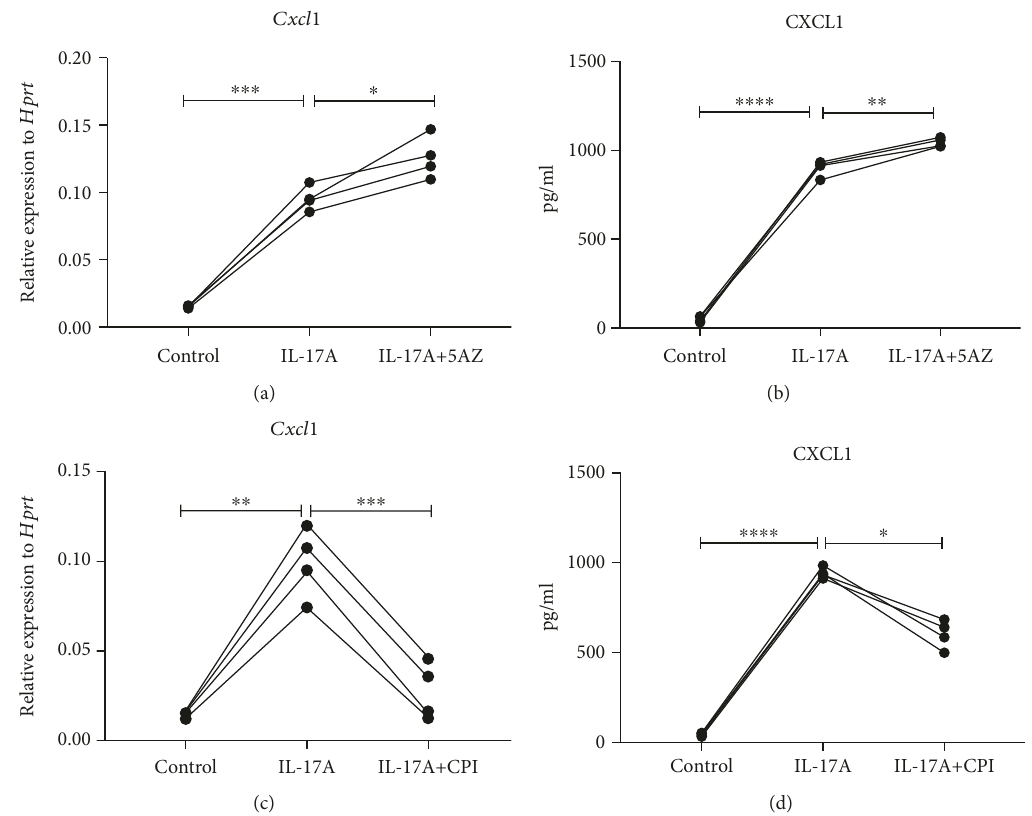
Figure 7: Epigenetic regulation of IL-17 pathway in mouse airway epithelial cells. Murine lung epithelial (MLE12) cells were cultured with HITES (hydrocortisone, insulin, transferrin, estradiol, and selenium) medium containing 10% fetal bovine serum (FBS) and antibiotics at 37 ° C in an incubator containing 5% CO . Cells were treated with control medium, 50 ng/ml m-IL-17A protein, 1 μ M 5-azacytidine, 2 200nM CPI, 50ng/ml h-IL-17A plus 1 μ M 5-azacytidine and 50ng/ml h-IL-17A plus 200nM CPI, respectively. 6h qPCR was performed for Cxcl1 mRNA production with (a) IL-17A/5-azacytidine and (c) IL-17A/CPI-treated cells. 24h supernatant was collected to reach CXCL1 protein level by ELISA for (b) IL-17A/5-azacytidine and (d) IL-17A/CPI-treated cells. ∗ p < 0 05 ; ∗∗ p < 0 01 ; ∗∗∗ p < 0 001 ; ∗∗∗∗ p < 0 0001 ; by a one-way ANOVA test. It is the representative fi gure from 4